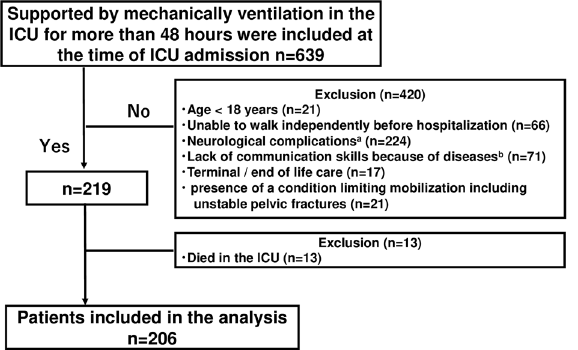
Figure 2. Algorithm to determine the primary barrier preventing mobilization. SpO 2 oxygen saturation of the peripheral artery, FiO 2 fraction of inspiratory oxygen, RASS Richmond agitation sedation scale, BPS behavioral pain scale, NRS numerical rating scale. The barrier to mobilization was determined by the intensivist in